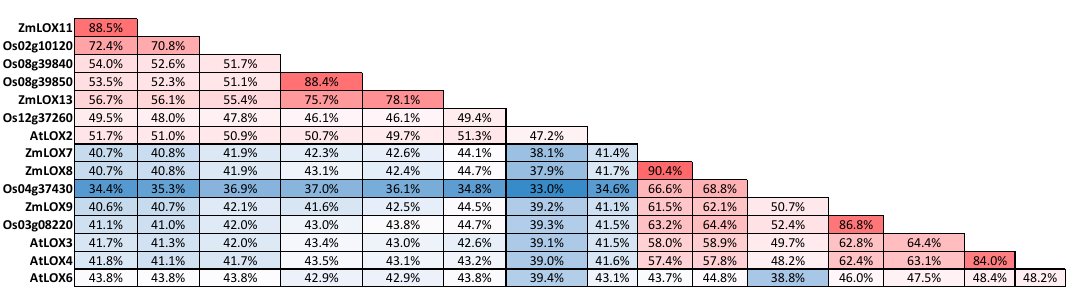
Figure 5. Protein sequence identity comparison of the 13-LOX family members from Arabidopsis , maize, and rice. Analyses was performed with Sequence Identity and Similarity software (SIAS; http://imed.med.ucm.es/Tools/sias.html). The color code (red to white to blue) scale represents the percent sequence identity from greatest to least.